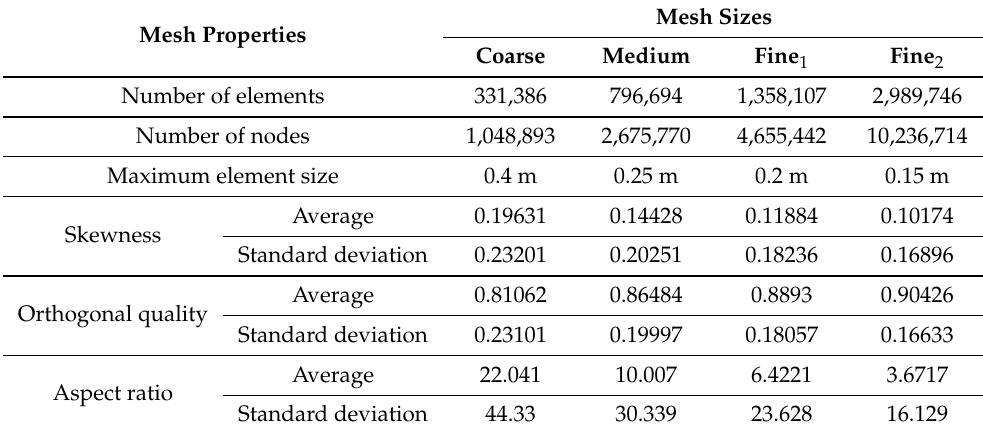
Table 3. Properties of the meshes analysed.